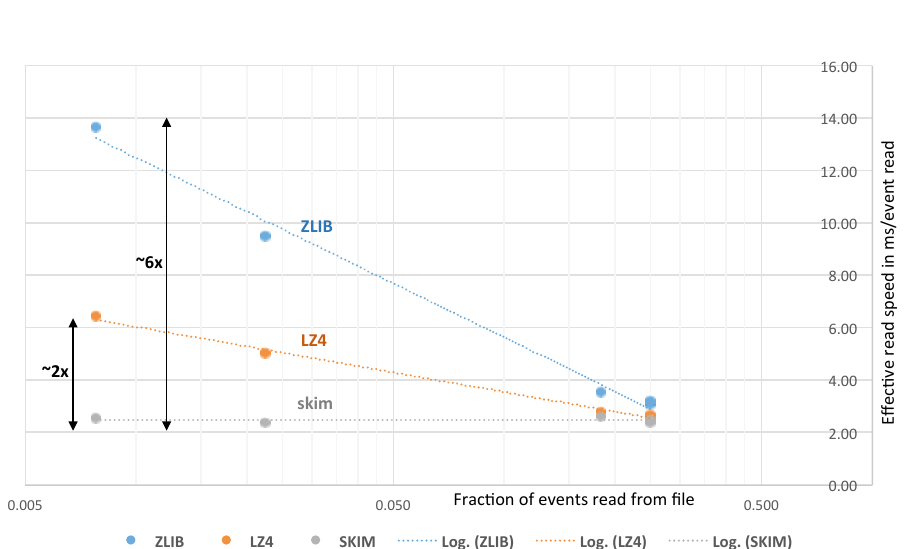
Figure 5. Effects of different compression algorithms on selective reading performance compared to 100% read (skim). The read time per event is constant for skimmed data file as it contains only preselected events. Read time per event goes up as selectivity increases for both ZLIB and LZ4 because there are less and less relevant events in every decompressed